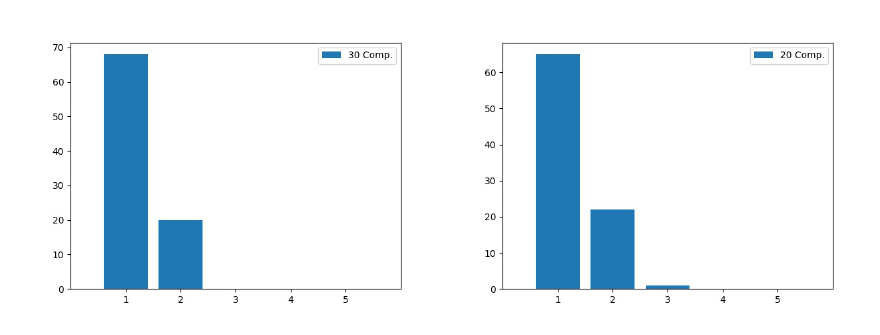
Figure 6. Histograms of rank position while comparing the Euclidean distance among feature vectors and varying the number of retaining components.